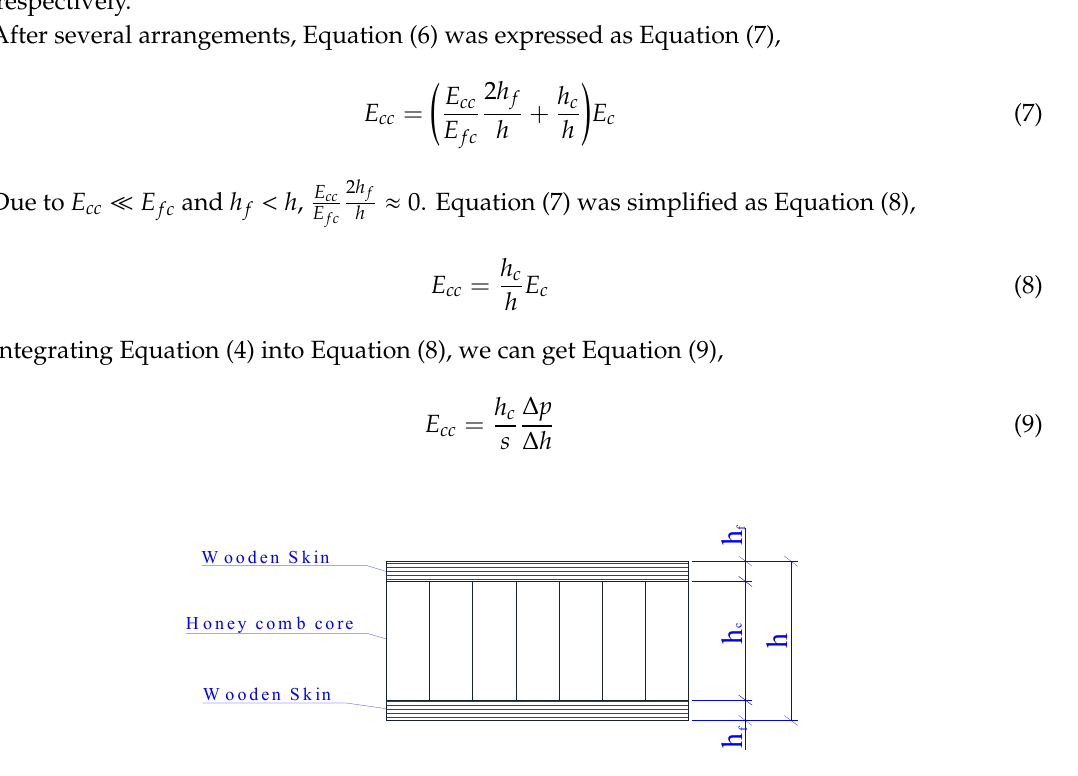
Figure 3. Notation of the sandwich structure with the Taiji honeycomb core.